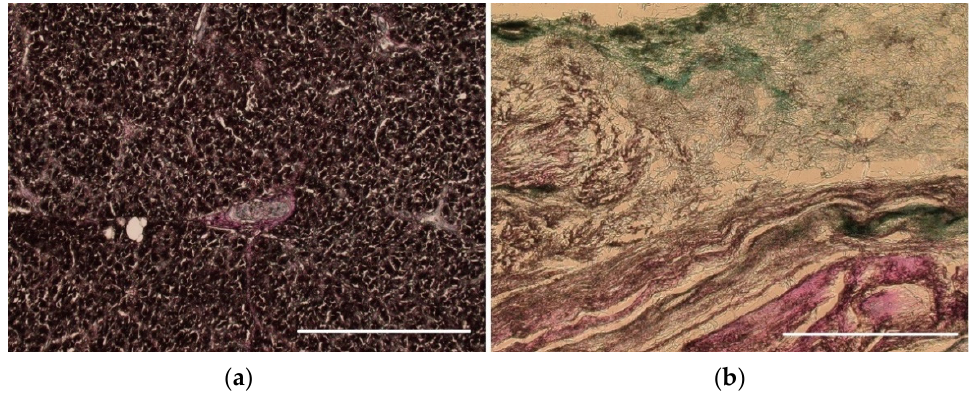
Figure 8. Microscopy images of native tissue (( a ); 100 µm; magnification 6.3 kx) and decellularized tissue (( b ); 100 µm; magnification 6.3 kx) stained with Alcian blue and van Gieson.